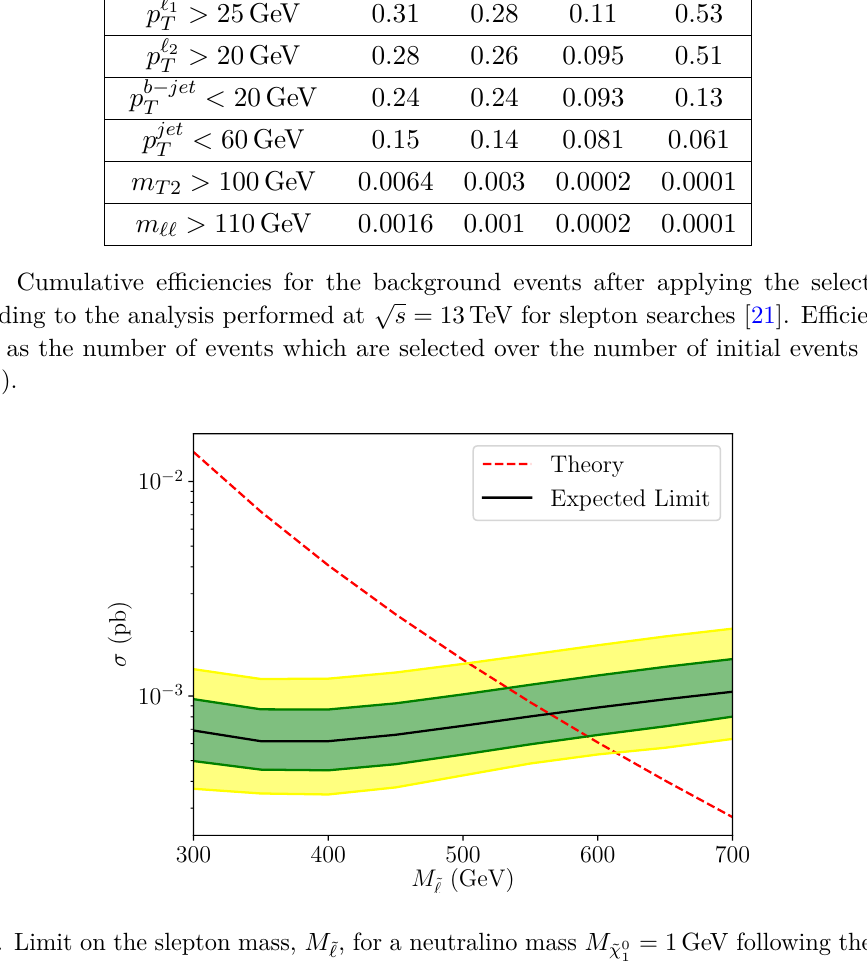
, for a neutralino mass M ‘